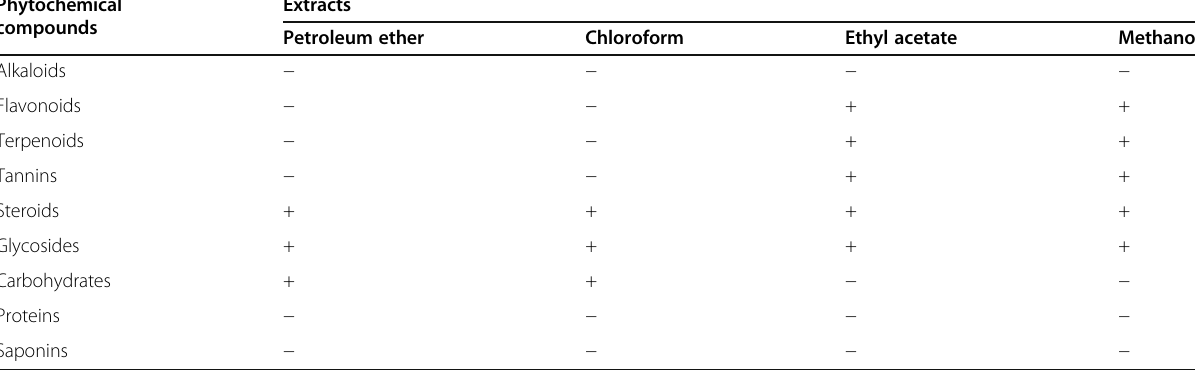
Table 1 Phytochemical analysis of different solvent extracts of E. cotinifolia Phytochemical compounds